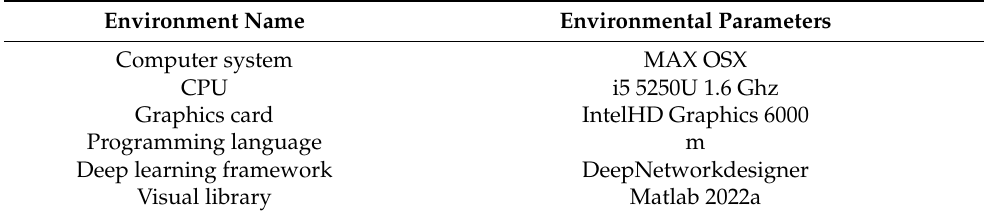
Table 1. Experimental environment configuration.